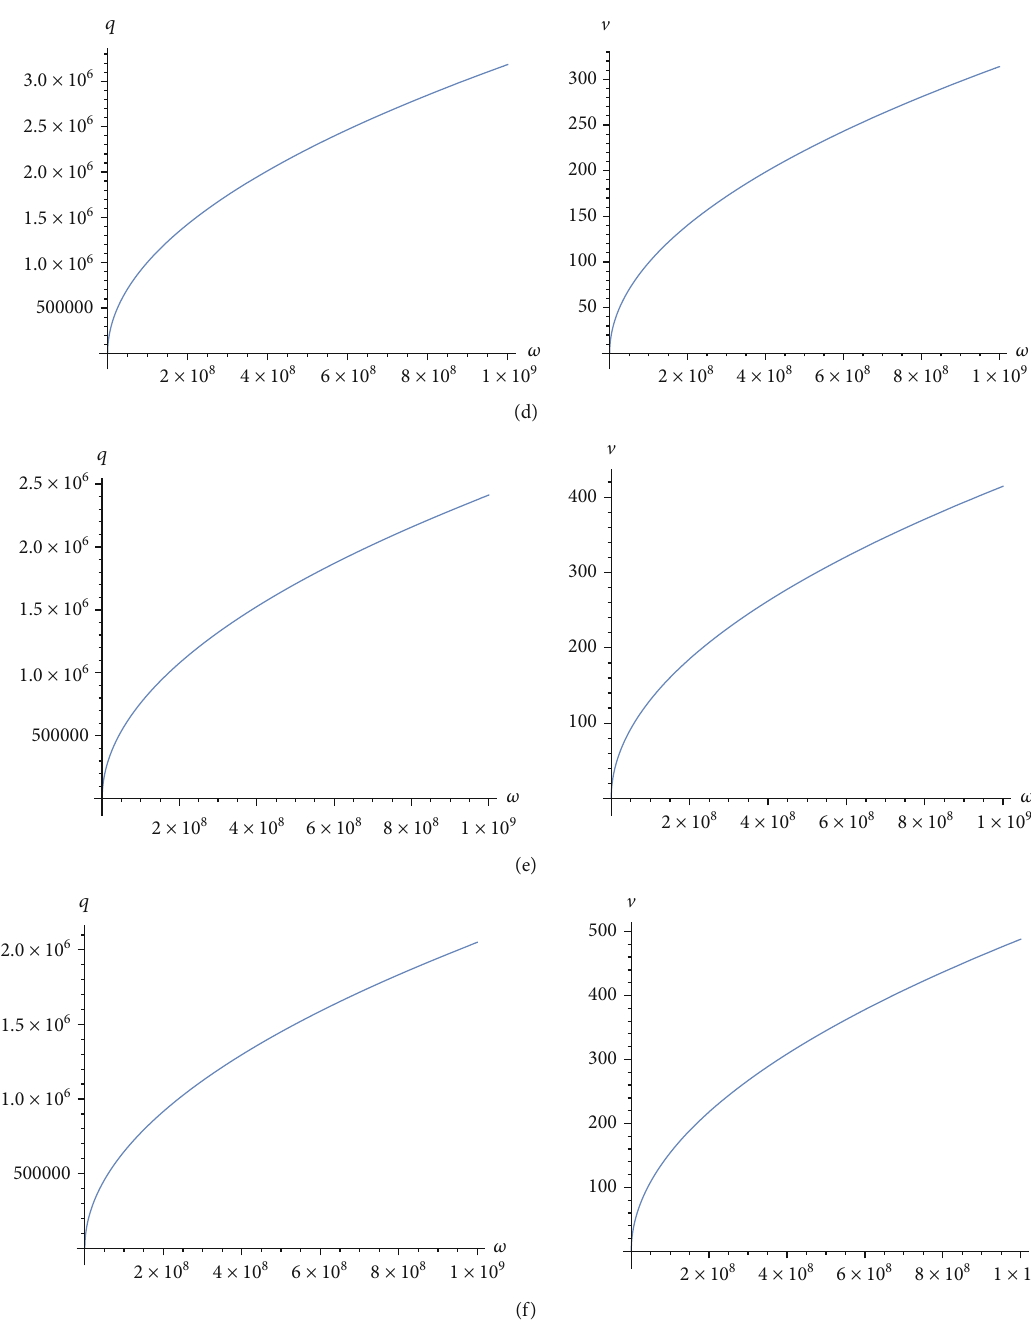
Figure 1: The dependence of the attenuation coe ffi cient and the phase velocity of the heat wave on the angular frequency in di ff erent mediums. (a) Quartz. (b) Calcite. (c) Bismuth. (d) Graphite. (e) Aluminum. (f)